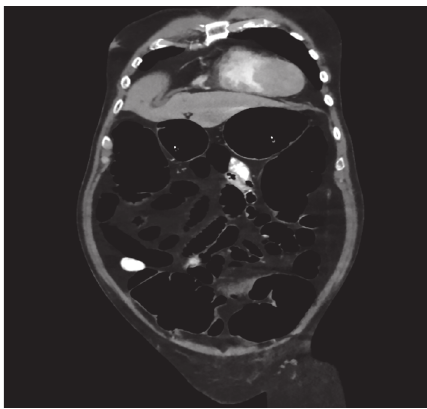
Figure 2: CT image of abdomen showing marked colonic dilation without any evidence of